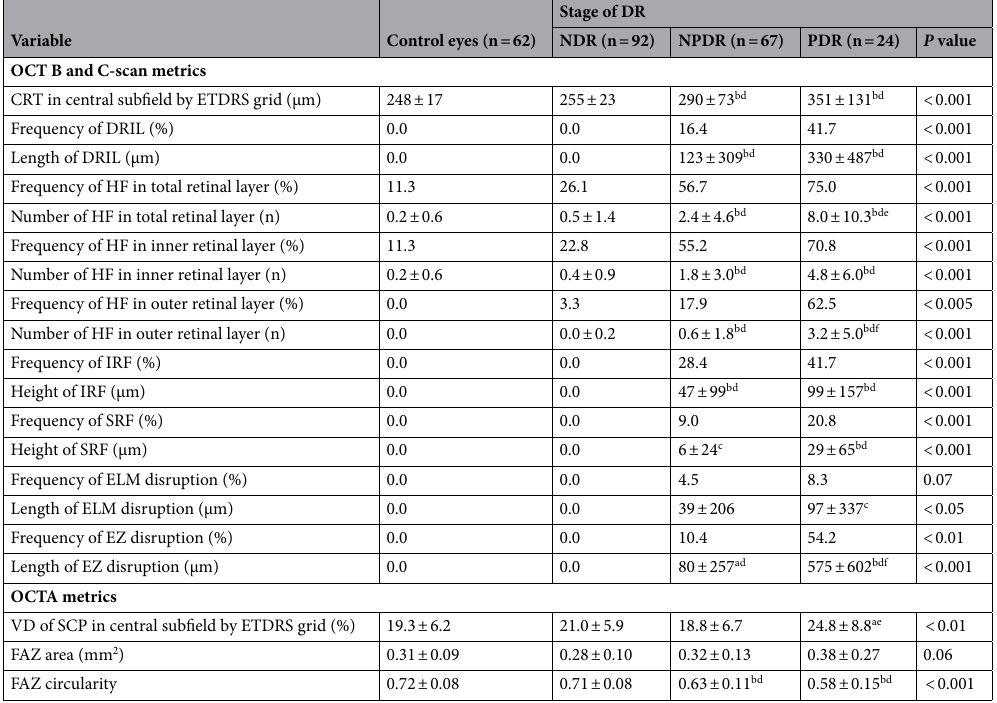
Table 2. Comparison of OCT-based factors in control eyes and at different stages of diabetic retinopathy. OCT, optical coherence tomography; DR, diabetic retinopathy; NDR, no DR; NPDR, no proliferative DR; PDR, proliferative DR; CRT, central retinal thickness; ETDRS, Early Treatment of Diabetic Retinopathy Study; DRIL, disorganization of retinal inner layer; HF, hyperreflective foci; IRF, intraretinal fluid; SRF, subretinal fluid; ELM, external limiting membrane; EZ, ellipsoid zone; OCTA, OCT angiography; VD, vessel density; SCP, superficial capillary plexus; FAZ, foveal avascular zone. a , P < 0.05 versus control; b , P < 0.01 versus control, c , P < 0.05 versus NDR; d , P < 0.01 versus NDR; e , P < 0.05 versus NPDR; f , P < 0.01 versus NPDR.